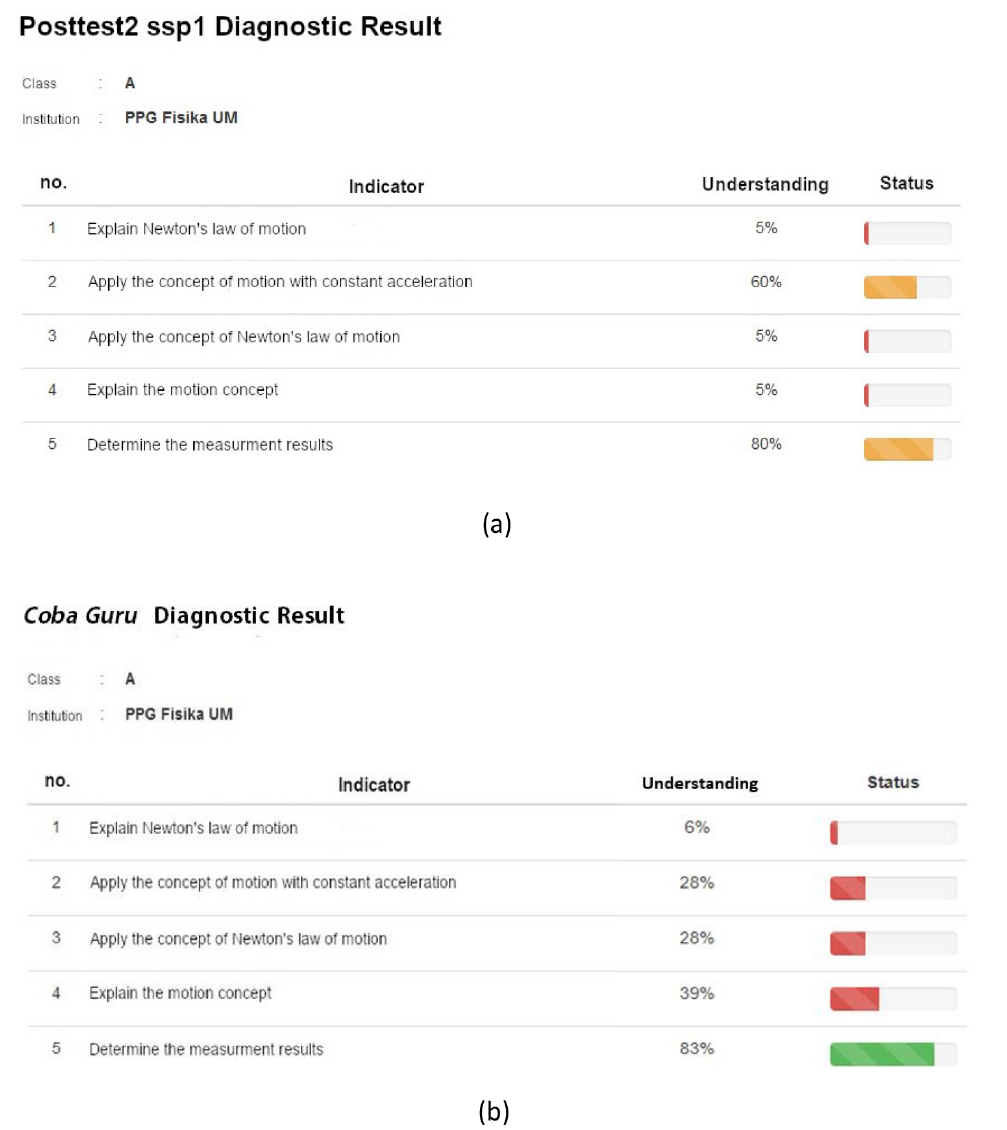
Figure 5. Example of Groups’ Feedback (a) prospective teacher, (b)